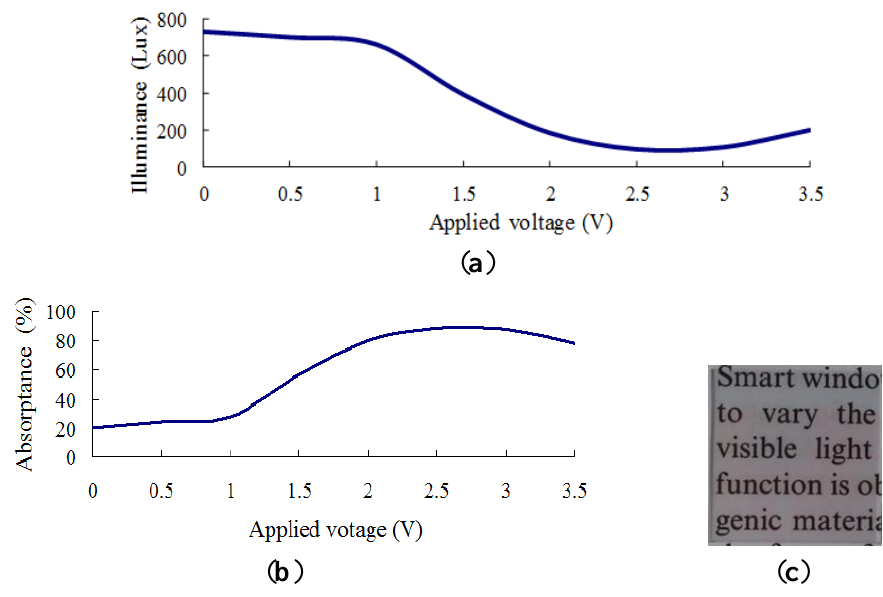
Figure 8. Transmittance and absorptance properties of ITO/WO electrolyte/ITO stack given electrolyte thickness of 500 nm and incident illuminance of 900 Lux. ( a ) Transmittance given applied voltage of 0–3.5 V; ( b ) absorptance given applied voltage of 0–3.5 V; and ( c ) transparency of EC stack given no applied